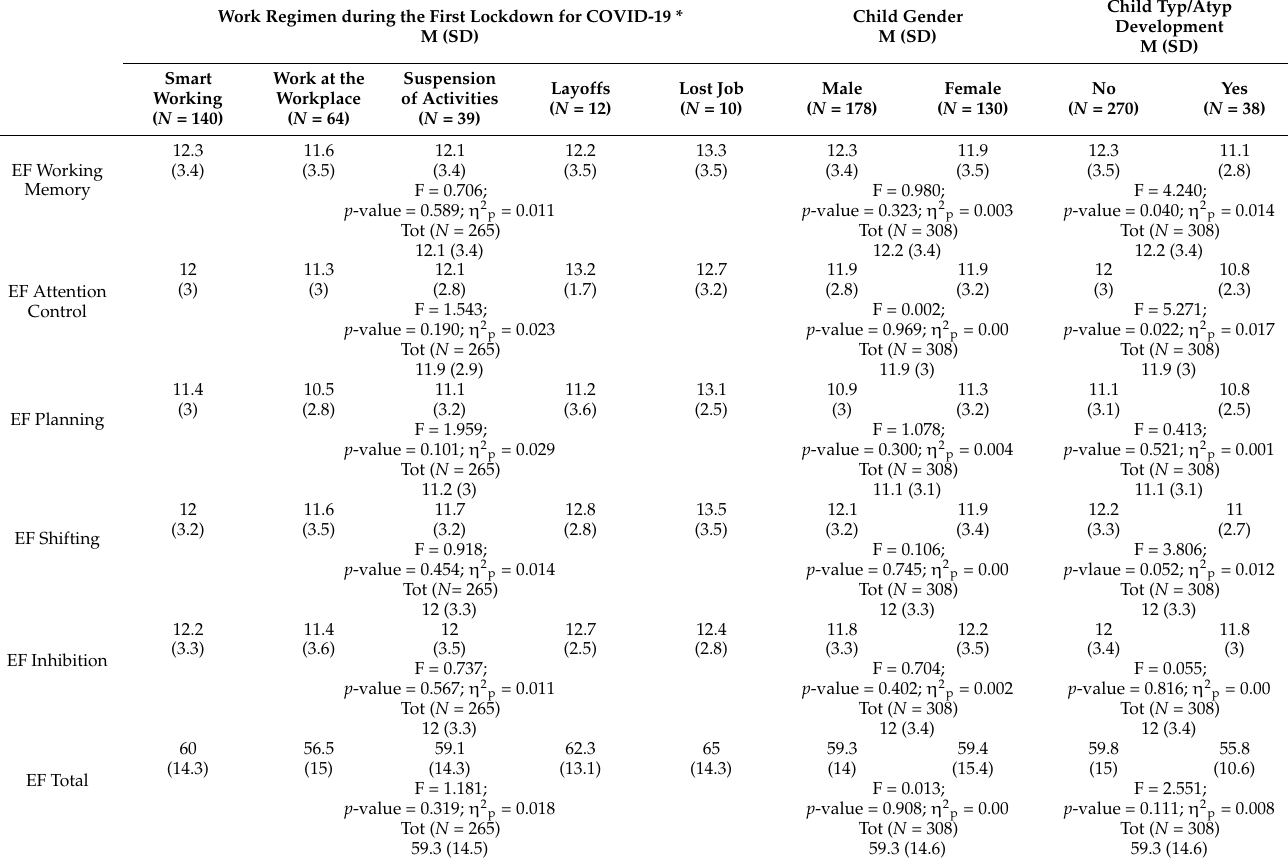
Table 9. EF descriptive data and ANOVA analyses for parental work regimen during the first lockdown, child gender, and child with typical/atypical development condition.